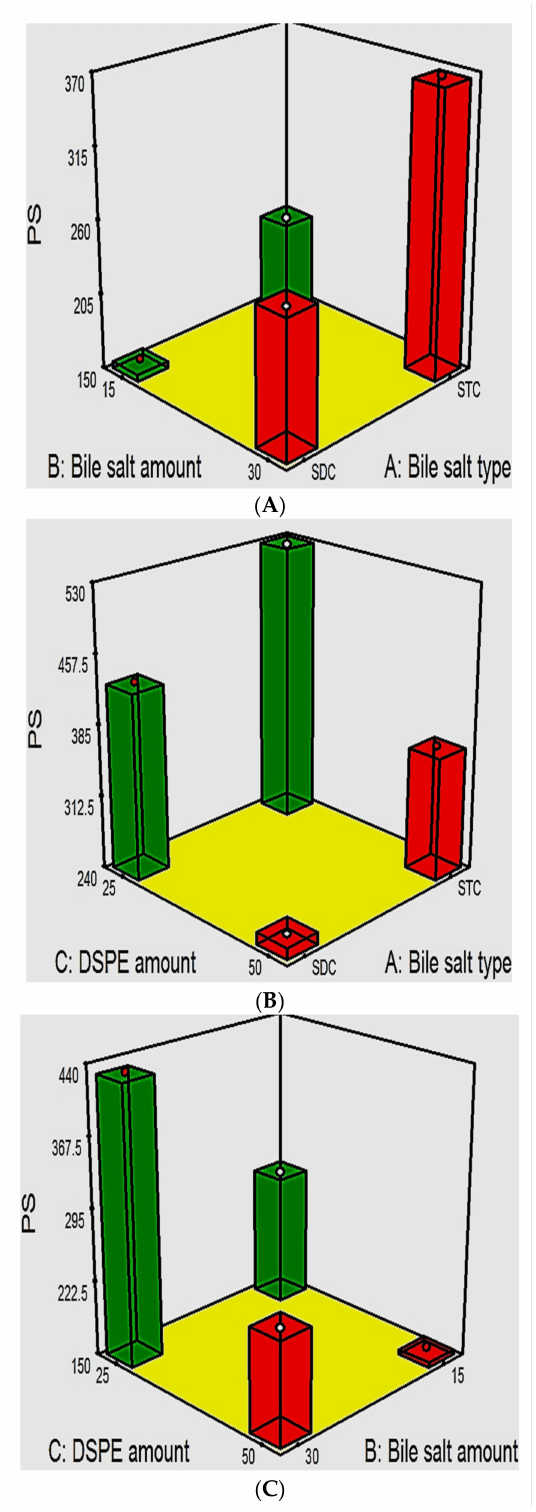
Figure 10. 3D surface response plots exploit the impact of ( A ) Bile salt type, ( B ) Bile salt amount and ( C ) DSPE–mPEG-2000 amount on PS of 4e -loaded PEGylated